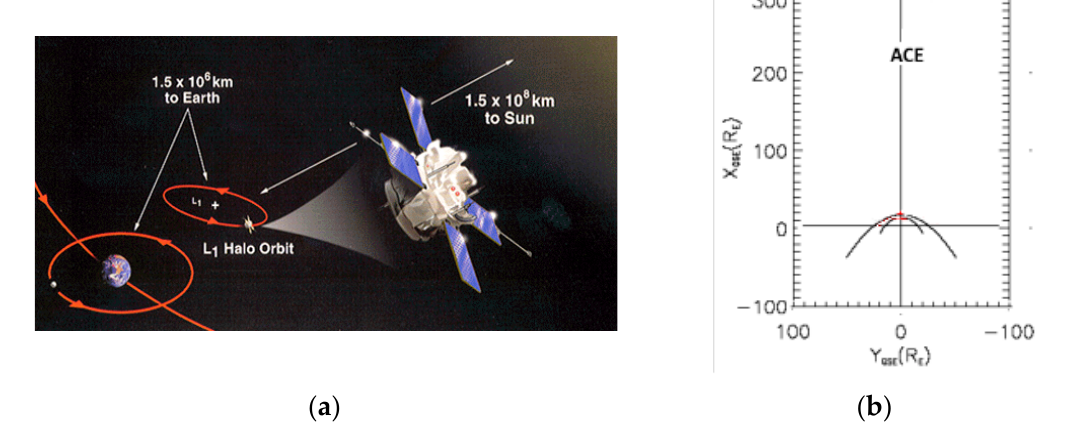
Figure 2. ( a ) ACE circulating around the L 1 Lagrangian point ( b ) The L 1 Earth–Sun gravitational equilibrium lies at a distance of ≈ 220 R E .